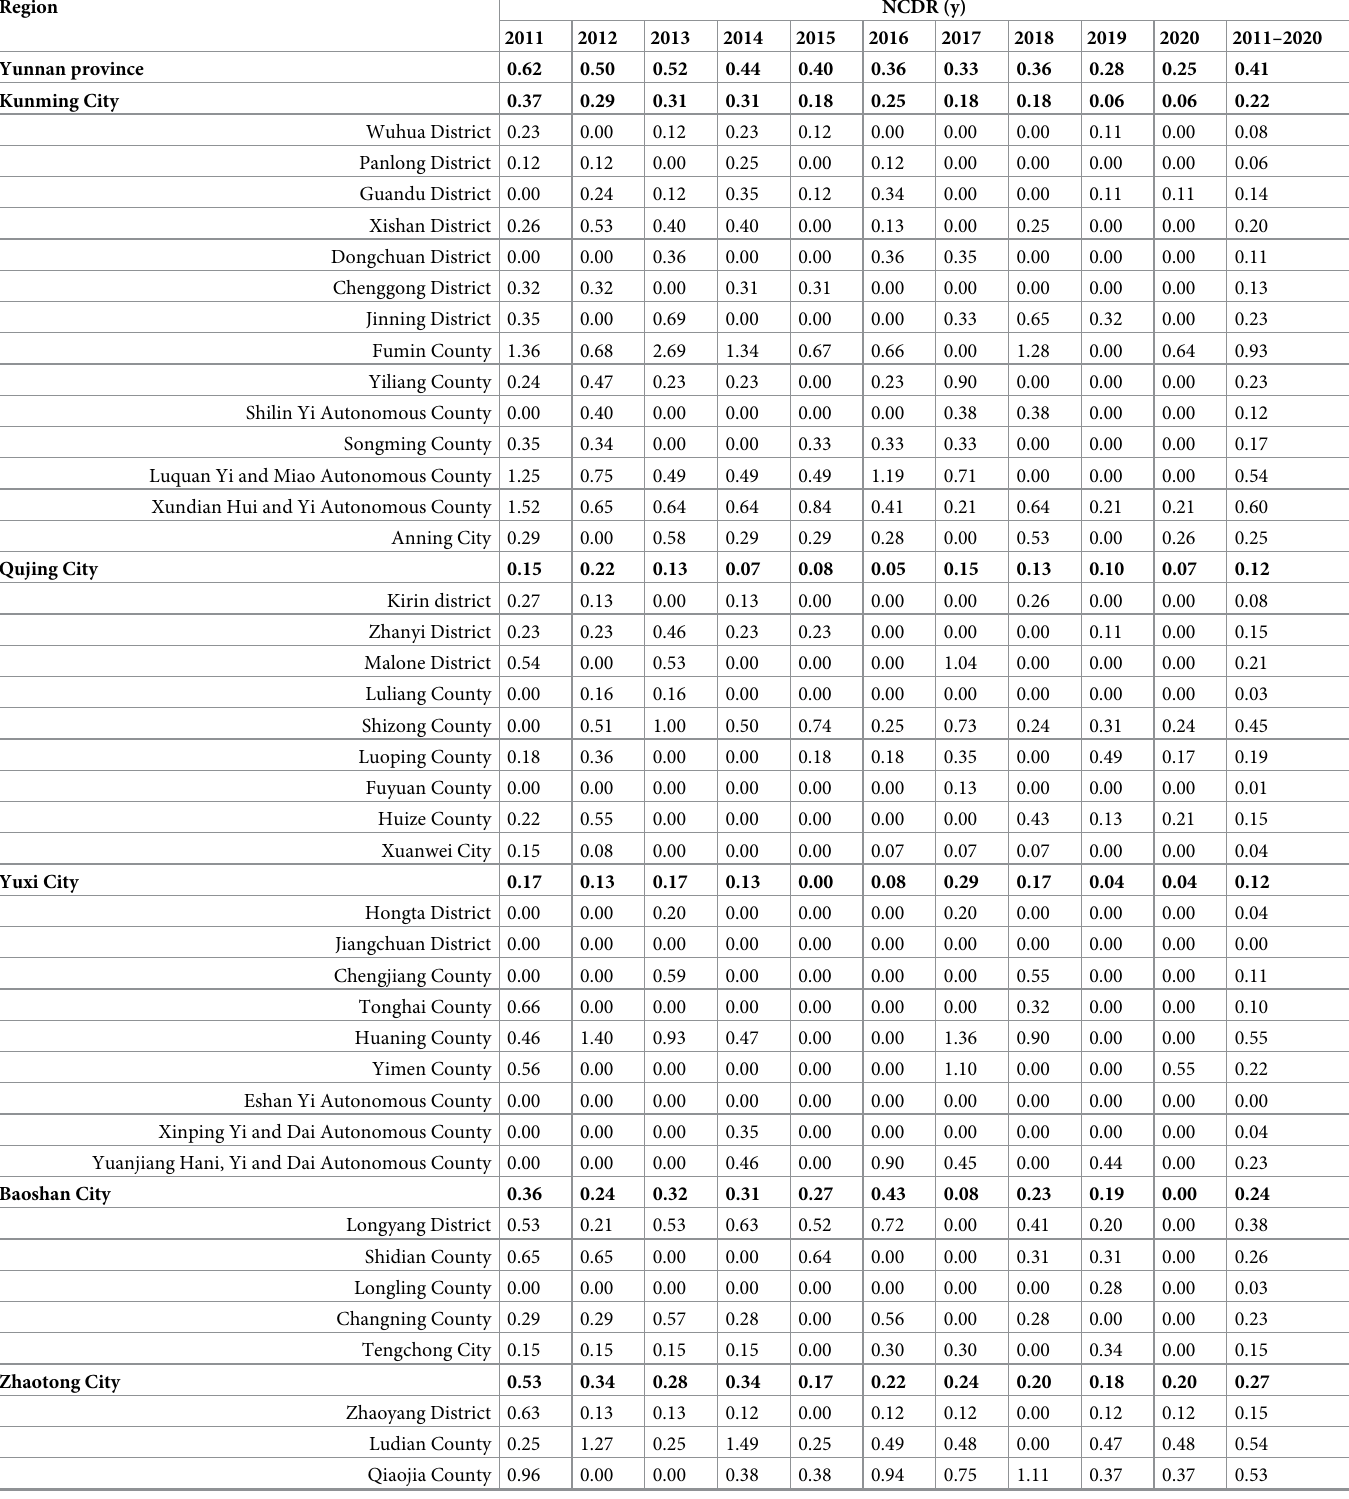
Table 2. Spatial distribution of newly detected leprosy cases in Yunnan, China, 2011–2020.